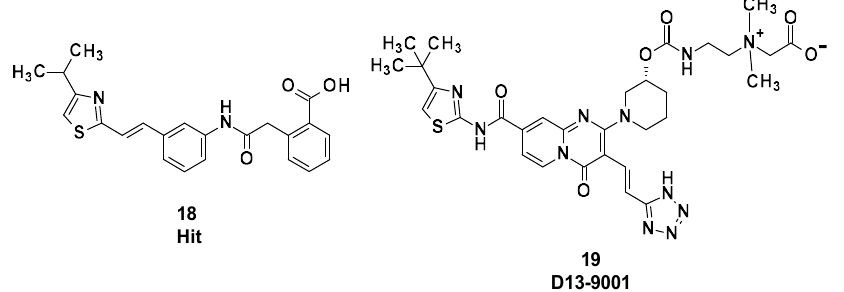
Figure 4. Structure of the hit compound 18 and of D13-9001 ( 19 ).